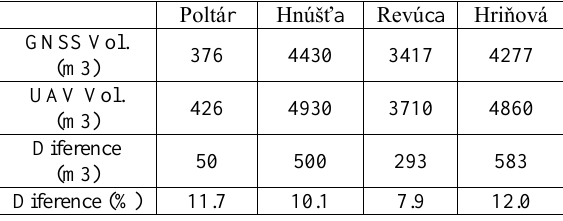
Table 3. Derived volumes from GNSS and UAV